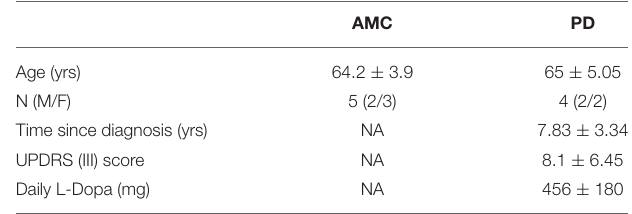
TABLE 1 | Clinical information on study